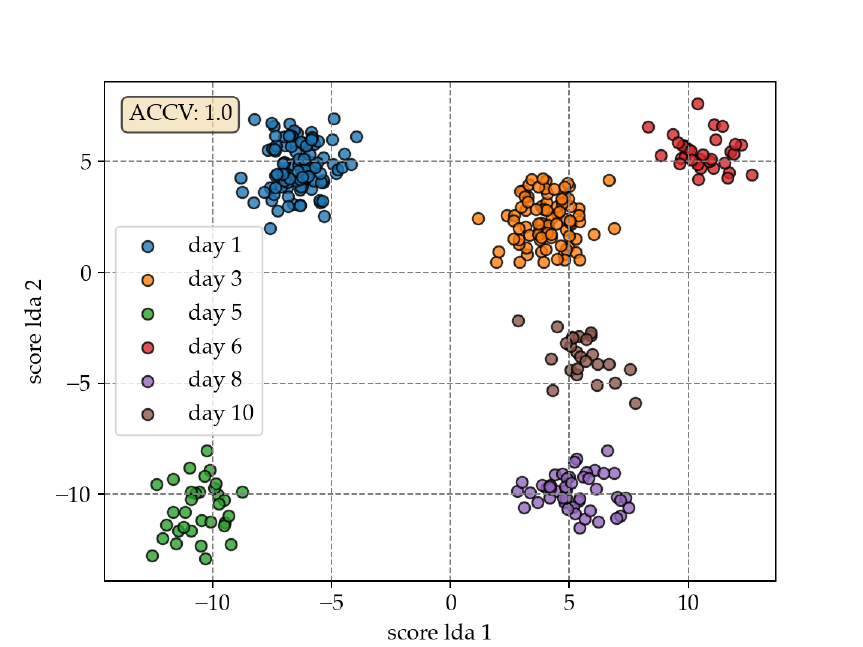
Figure 4. LDA scores based on OpenVNT Vis29 spectral data.